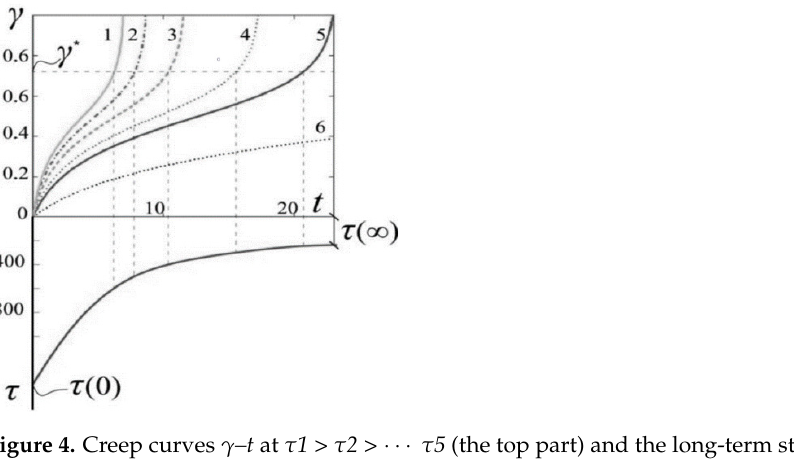
Figure 5. ( a ) τ –t curves made using the kinematic testing results at different values of γ ̇ =const , γ ̇ 1 > γ ̇ 2 > ⋯ γ ̇ 5 ; ( b ) shear stress relaxation curves τ (t) at different initial shear stresses τ (0) and γ = const . Hence, one function can be used to obtain all three types of rheological curves, including curves for creep, represented as γ –t curves at different τ – τ * = const (see Figure 4), kinematic shear τ –t at different ( γ · = const ) (see Figure 5a), and relaxation τ –t at different initial τ (0) and γ (0) = const (see Figure 5b). It is noteworthy that in many cases these curves, determined using the new rheological equation (Formula (5)), coincided with the curves obtained as a result of laboratory testing conducted by different researchers [2,18–23,27]. It is also important that these curves were drawn using the same rheological parameters ( α , β , a and b ). Therefore, the authors’ approach has a significant advantage over the technology of A.R. Rzhanicyn [35], who recommended to plot the double-creep curvature (see Figure 3) in parts. The system of H. Hencky’s physical equations [3], that allows determining linear and non-linear dependences between stresses and strain rates, has the following form: * (